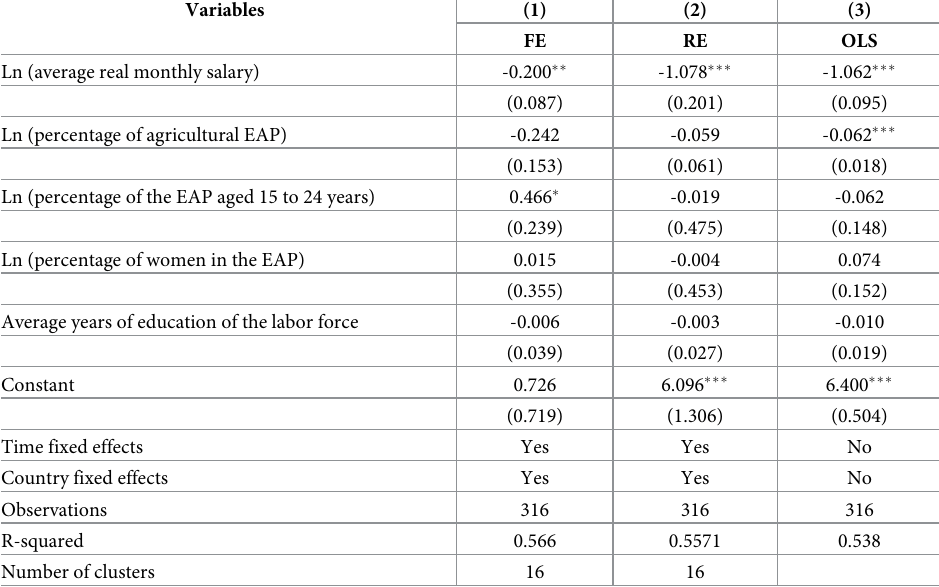
Table 6. Estimate for Latin America of the correlation between the informality rate and the average monthly salary. Variables (1) (2)